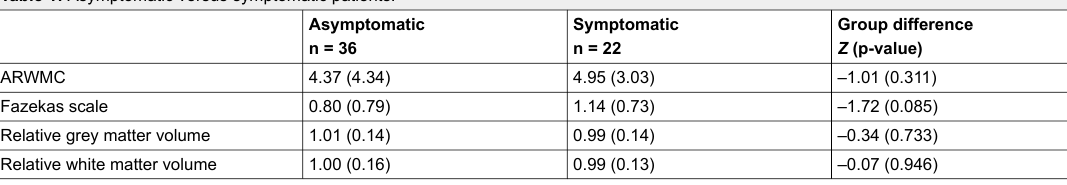
Table 1: Asymptomatic versus symptomatic